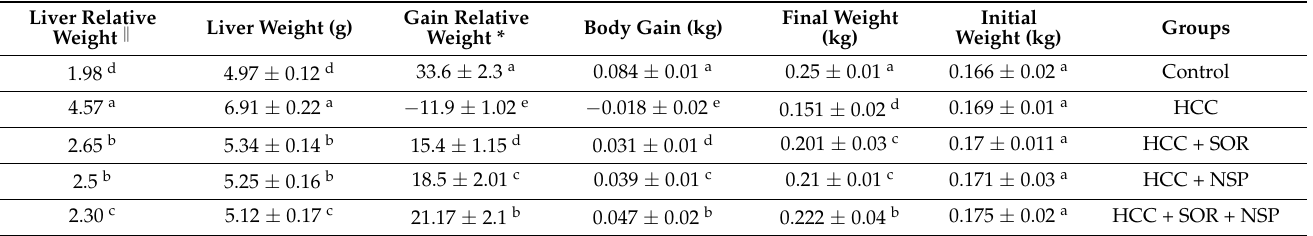
Table 2. Effects of SOR, NSP, and their combination in DENA-induced HCC on body and liver